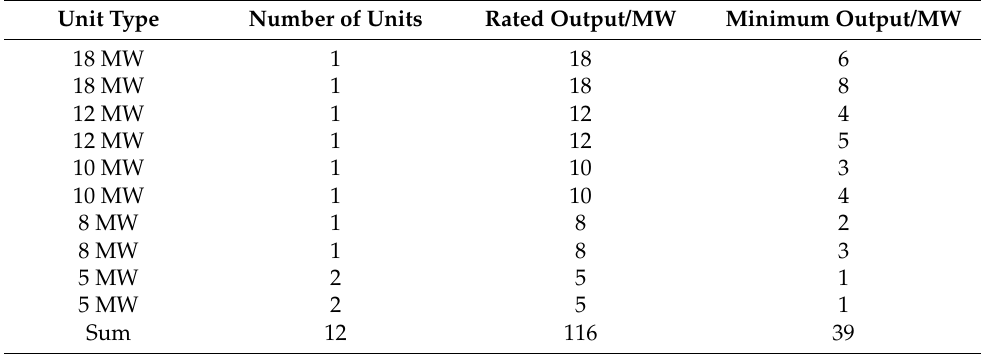
Table 1. Operation modes of generator units.